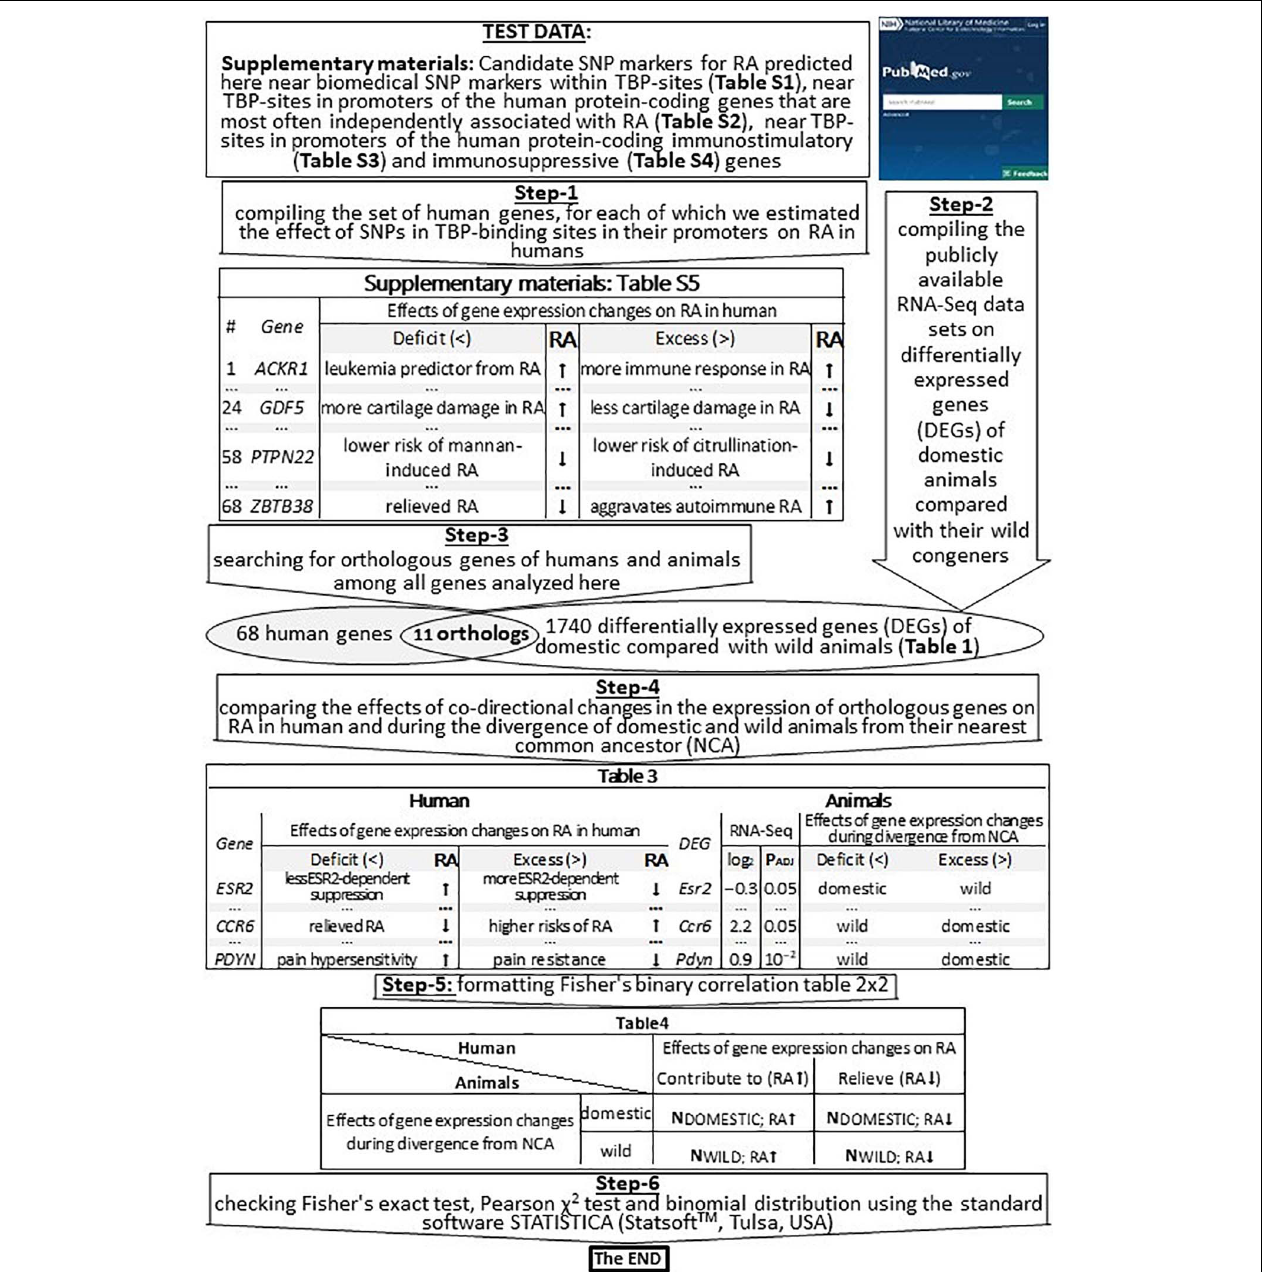
FIGURE 2 | An algorithmic flowchart of in vivo validation of our current predictions by means of publicly available RNA-Seq data on differentially expressed genes (DEGs) of domestic vs. wild animals. RA, rheumatoid arthritis; effect on RA, contributes to ( ↑ ), relieves ( ↓ ); NCA, nearest common ancestor; P ADJ , significance [Fisher’s Z -test with those corrections on multiple comparisons that have been published by Albert et al. (2012), Hekman et al. (2018), and Yang et al. (2018)].